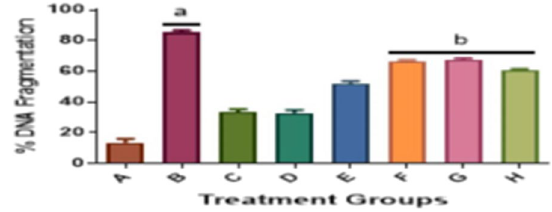
Fig. 3 AEAC and Quercetin abrogated KBrO3-induced DNA fragmentation in the brain of male Wistar rats. Values are mean SD ± (n 5), a significantly different compared with the negative control = = group A (p < 0.050). b significantly different compared with the = positive control group B treated with KBrO3 only (p < 0.05). Group A received distilled water, B: 30 mg/kg KBrO3, C: 50 mg/kg Quercetin, D: 300 mg/kg AEAC, E: 150 mg/kg AEAC, F: KBrO3 300 mg/kg AEAC, G: + KBrO3 150 mg/kg AEAC, H: KBrO3 + +